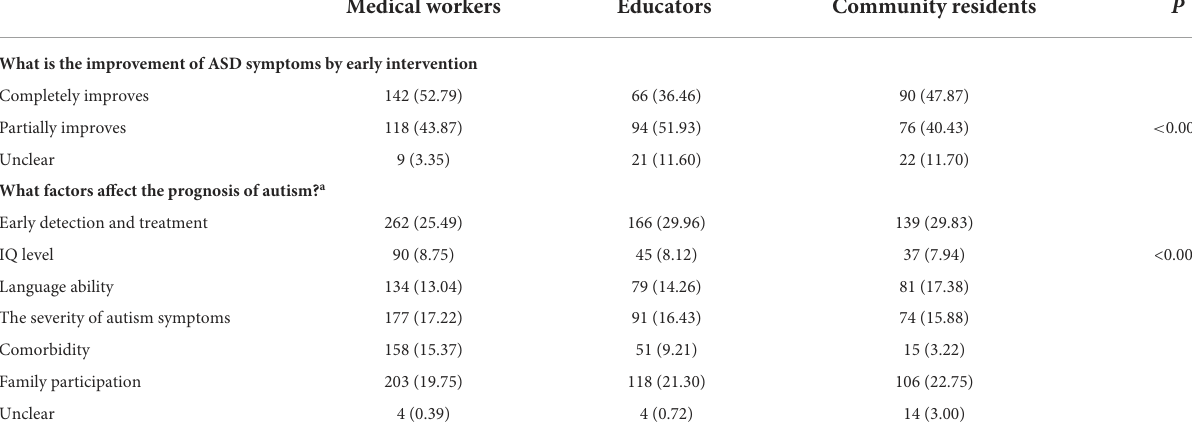
TABLE 6 Access to ASD information.